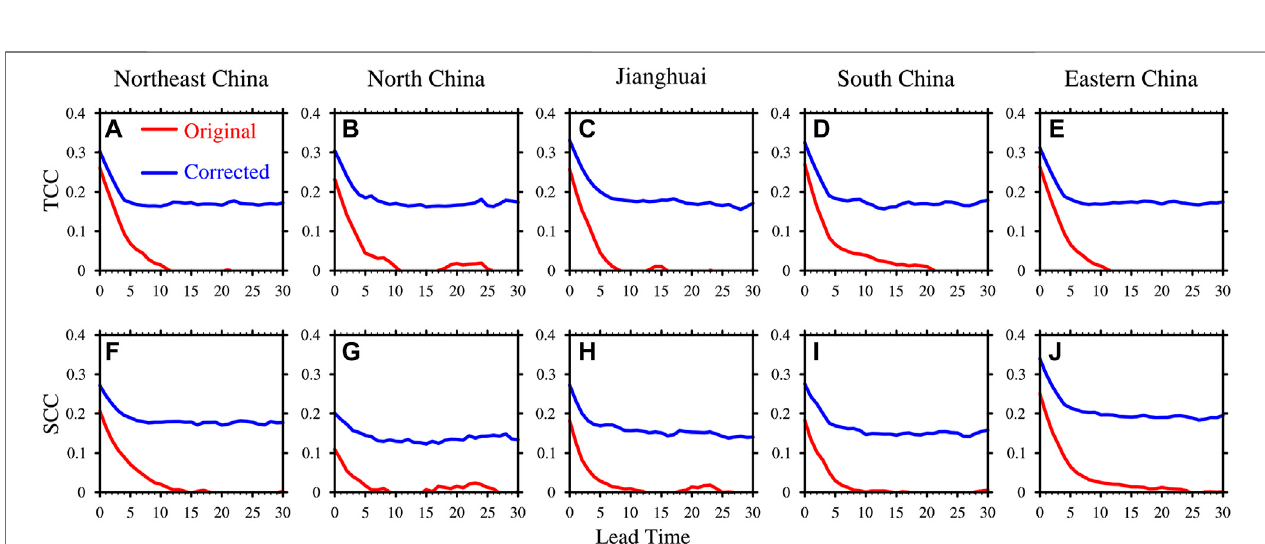
FIGURE 9| The 20-year average TCC (A – E) and SCC (F – J) of the original and bias corrected predictions with different forecast lead time (days) withobservations averaged over each